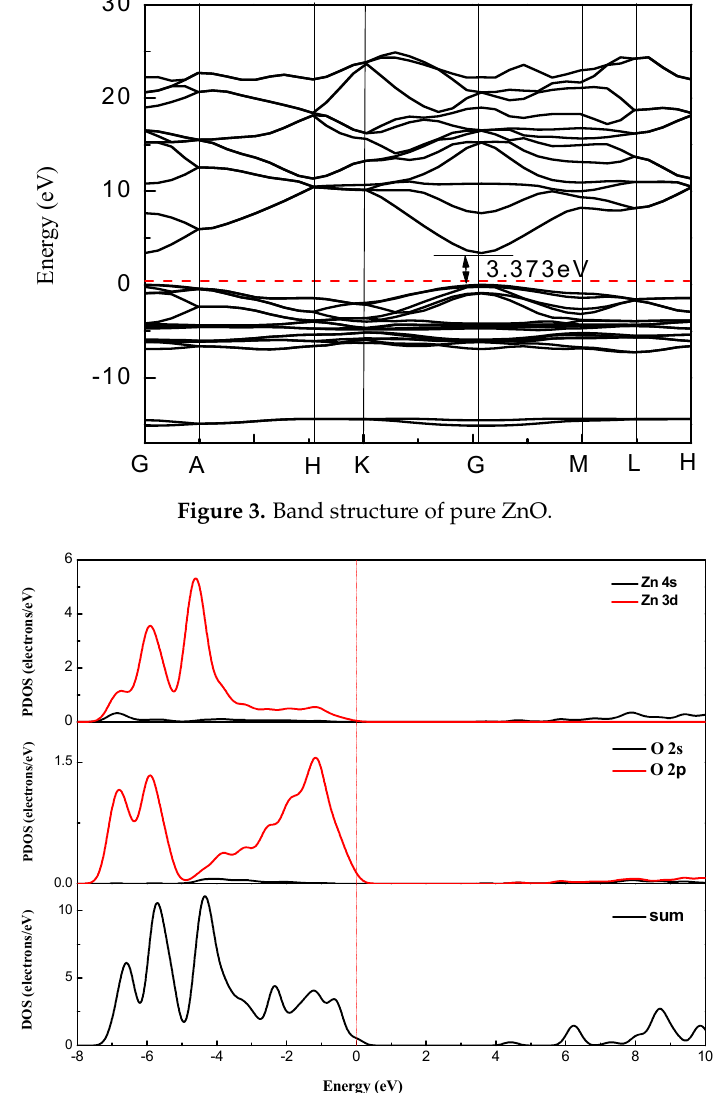
Figure 4. Partial density of states (PDOS) for pure ZnO.